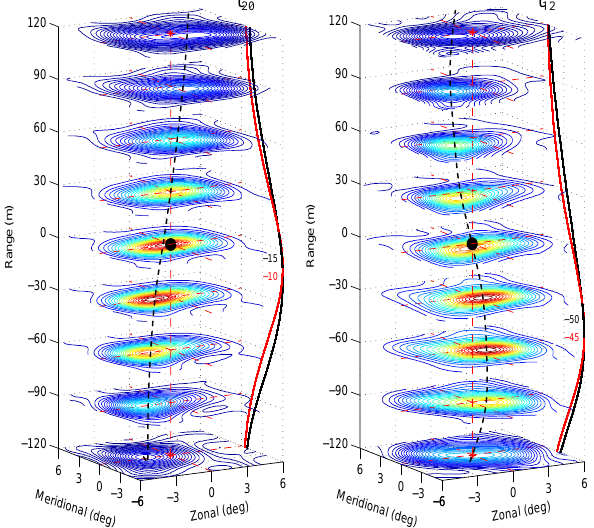
Figure 5. Same as Figure 3, but showing the imaging results at the time slots 20 and 12 indicated in Figure 2(d). Mitigation of spatial weighting effect is made.